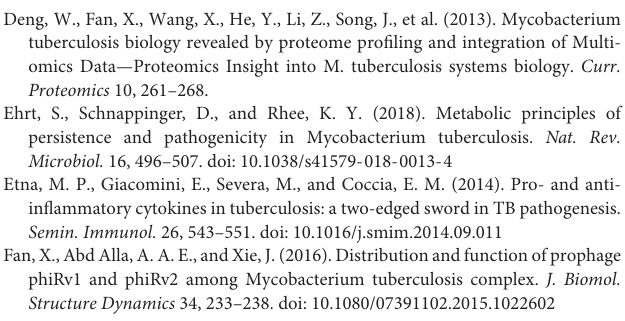
Supplementary Figure 1 | Map of plasmid pNIT-Myc-Rv2650c. Supplementary Figure 2 | Comparison of the morphology of the recombinant M. smegmatis MS_Rv2650c and MS_Vec. (A) MS_Rv2650c and MS_Vec strains were cultured in 7H9 medium with 0.05% (v/v) Tween 80 and 28 mM ε -caprolactam at 37 ◦ C until an OD 600 of 0.6–0.8 were reached. The cultures were kept at room temperature for 30 min. (B) The cultures were harvested for scanning electron microscopy (SEM)